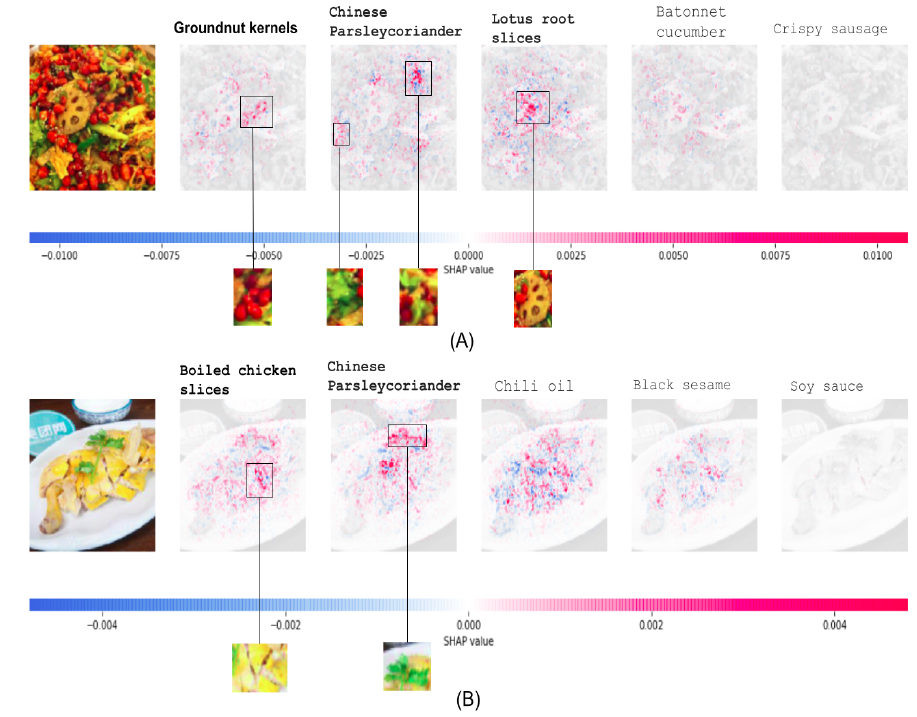
Figure 16. ( A , B ) Randomly selected images with visually visible ingredients. The visualization shows that the SHAP values of the pixels from the visible portions of the ingredients in the food image have the highest contribution towards the most likely outputs. By using ranked_outputs = 5 we explain only the five most likely ingredients. Bold indicates the actual ingredients.